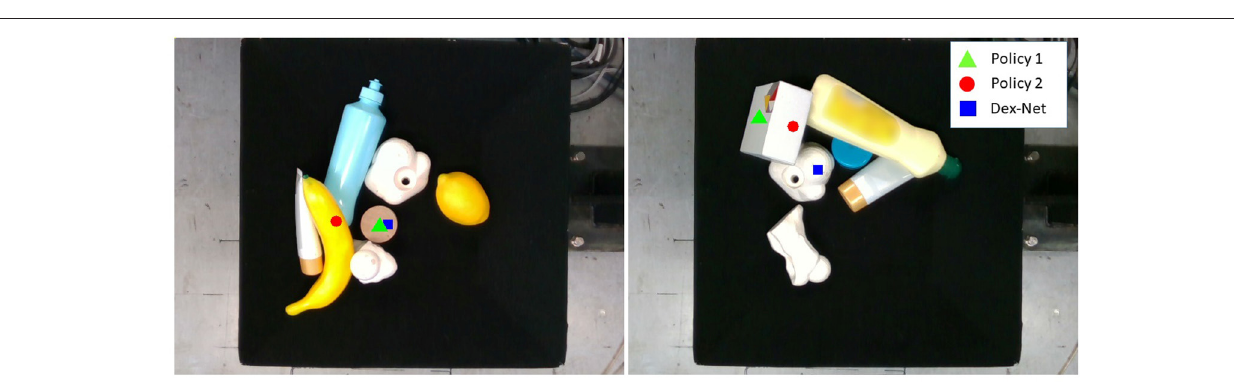
Frontiers in Neurorobotics |